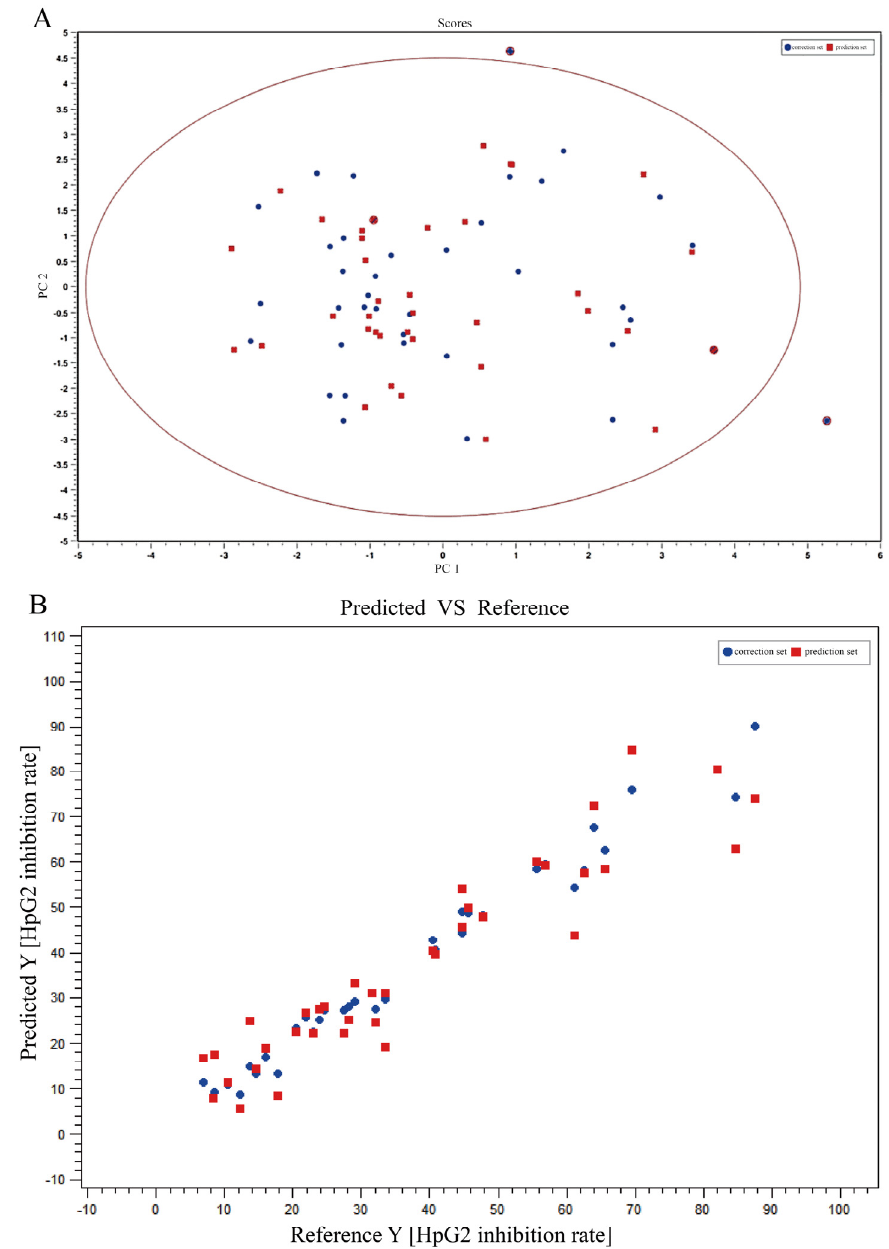
Figure 2. The spectral-effect relationships between the chemical composition and anti-cancer activity of T. hemsleyanum on HepG2 cells. PCA scores of metabolites of T. hemsleyanum extracts with respect to the anti-cancer IC 50 of HepG2 ( A ); PLS modeling of metabolites of T. hemsleyanum extracts with respect to the anti-cancer IC 50 of HepG2 ( B ). Table 2. Identi fi cation of chemical components of T. hemsleyanum metabolites associated with HepG2 hepatocellular carcinoma cells.